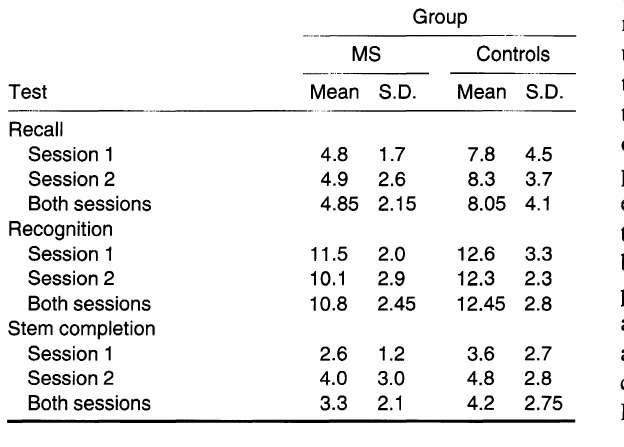
TABLE I. Scores on memory tests for MS and control subjects